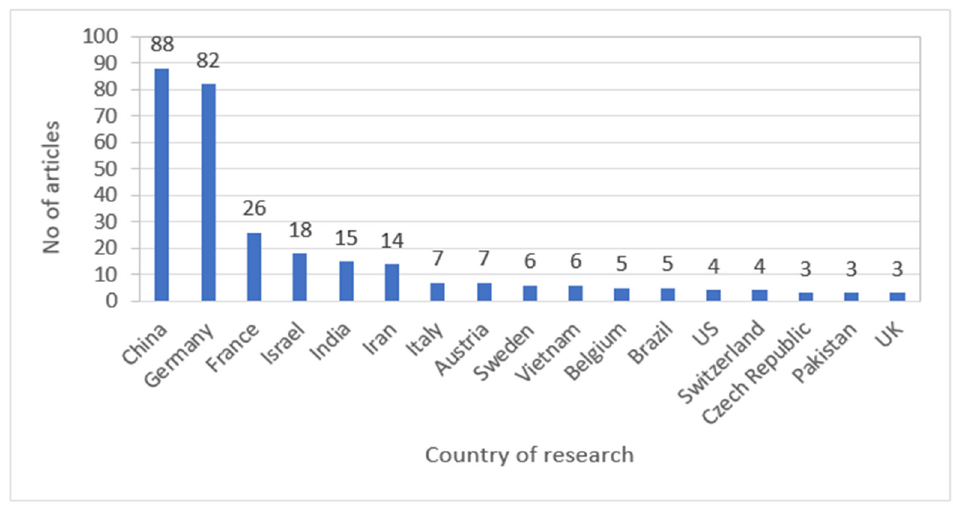
Figure 5. Distribution of publications according to country.